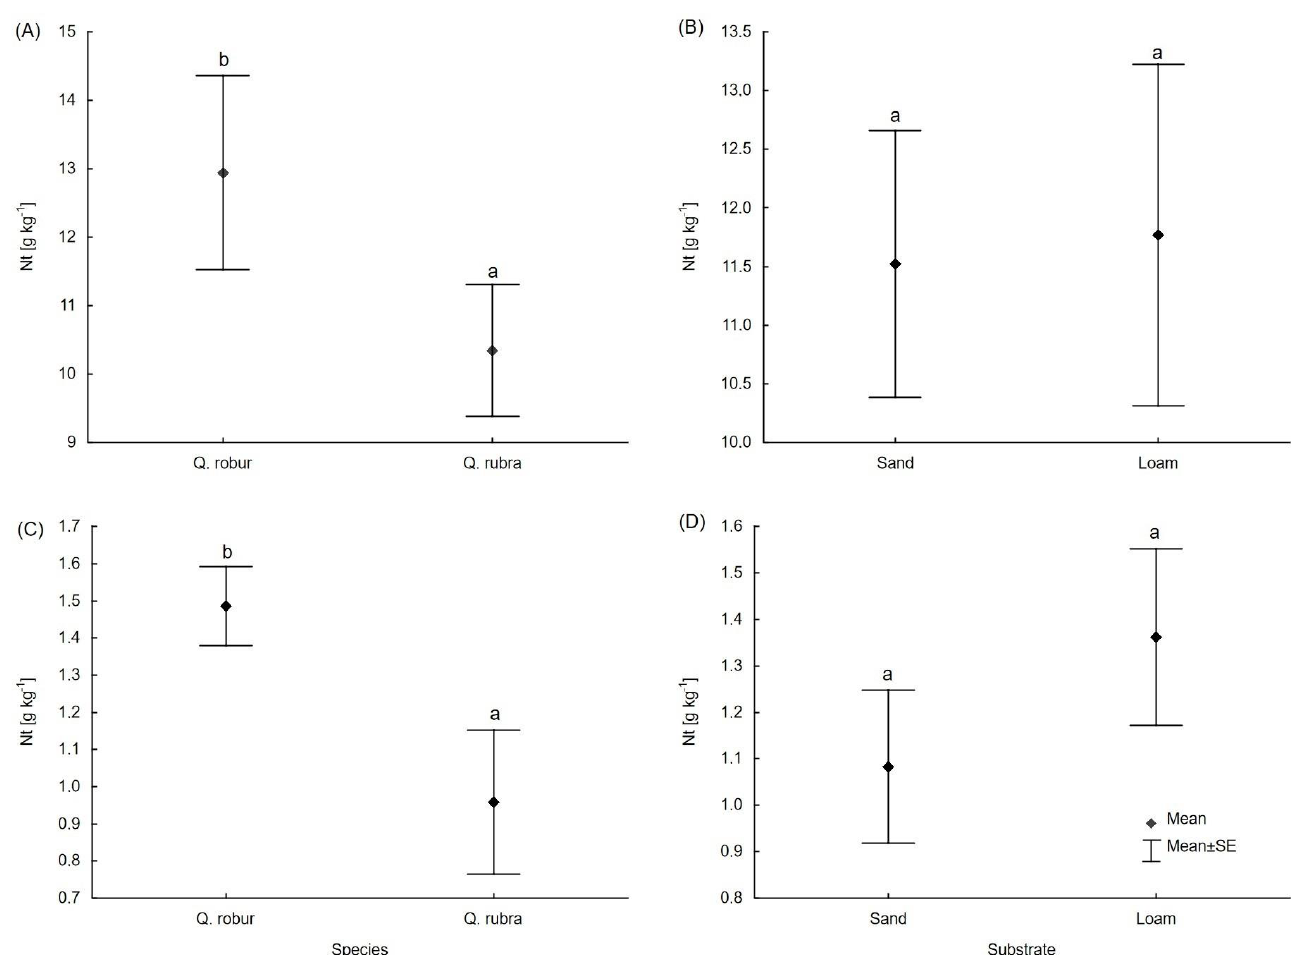
Figure 2. Nt content in litter Oi + Oe ( A , B ) and 0–5 cm mineral ( C , D ) horizons under two oak species on reforested post-fire site; means followed by different lowercase (a, b) are significantly different at p < 0.05.